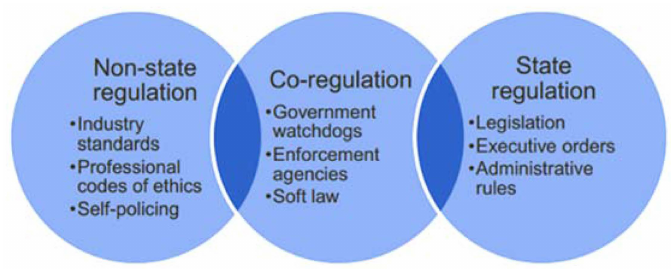
Figure 1. State vs. non-state regulatory options (Source: